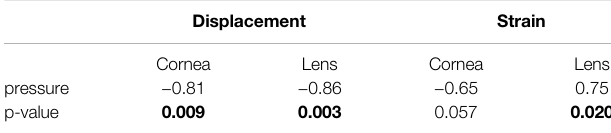
Bold text indicates statistical signi fi cance at p <